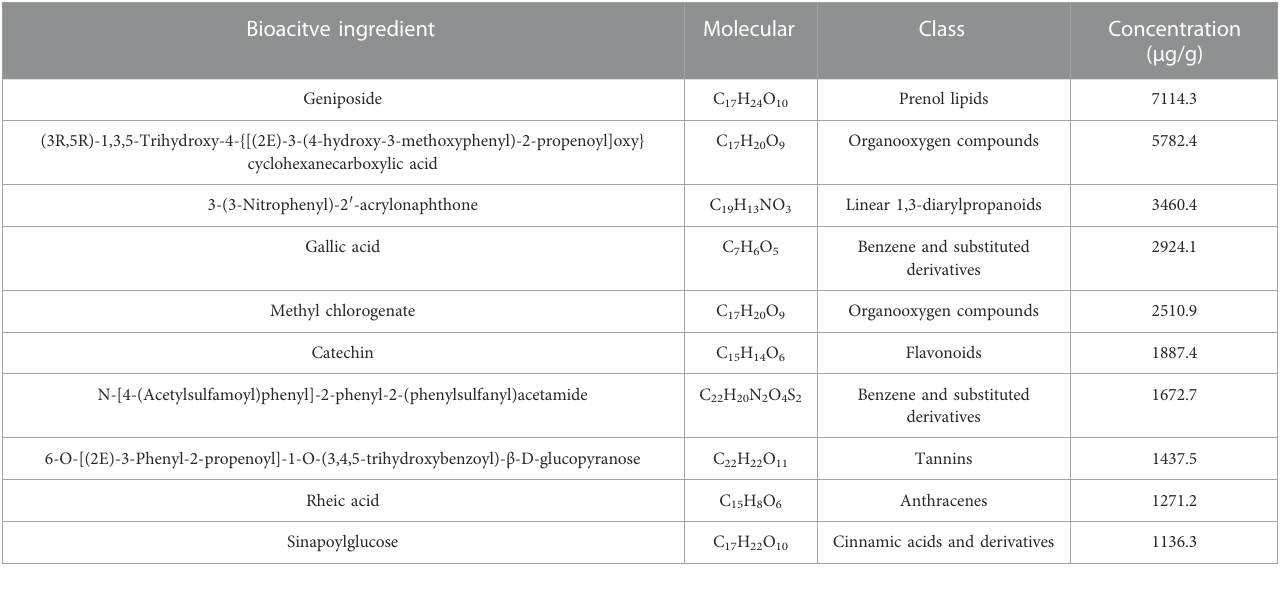
TABLE 3 Top 10 bioactive ingredients with the highest relative concentrations in SHCZF.